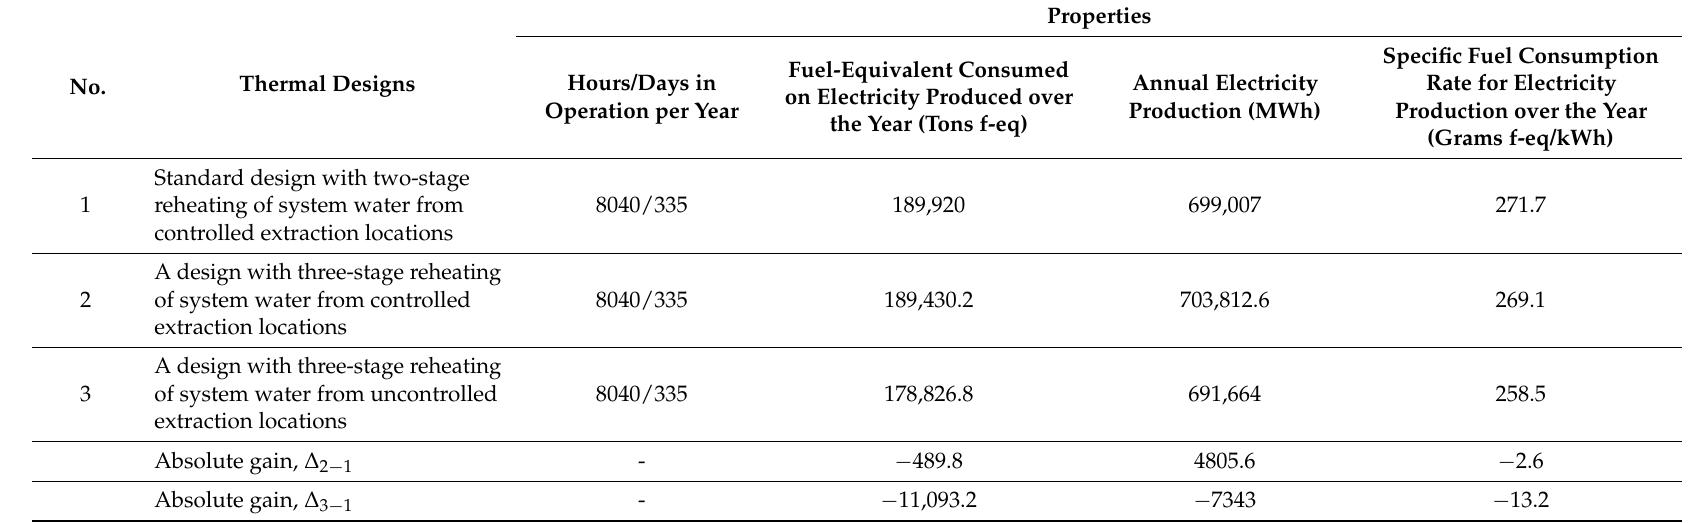
Table 2. Year-round efficiency of turbine unit thermal designs (aligned to the electrical grid schedule in the